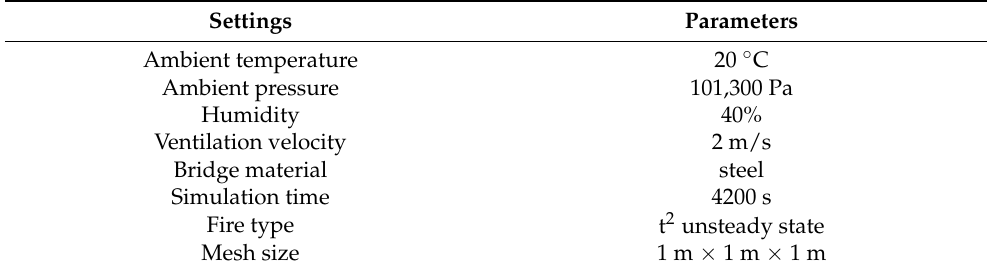
Table 2. Parameter settings of simulation.